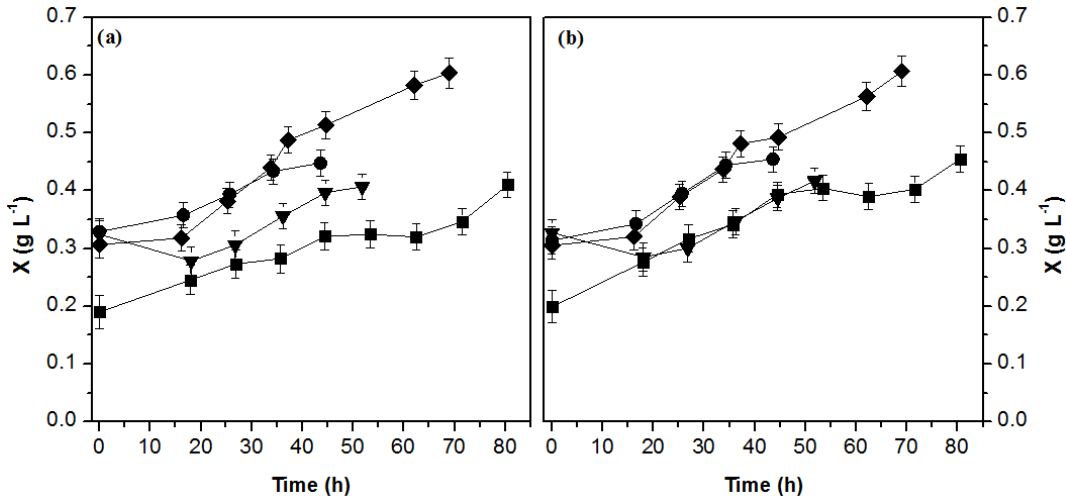
Figure 2. Temporal variation of biomass dry weight concentration ( X ) in photobioreactors (PBR 1 ) ( a ) and PBR 2 ( b ) for all assays: I— (cid:4) ; II— • ; III— (cid:72) ; IV— (cid:7) . Error bars correspond to the standard deviation of the mean determined for duplicates from two independent experiments.